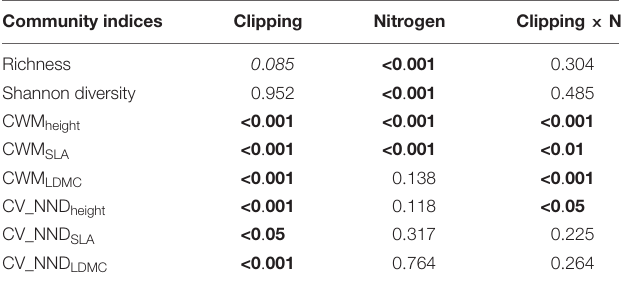
TABLE 1 | P -values of two-way ANOVA to evaluate the effect of clipping, nitrogen addition and their interaction on community indices. Community indices Clipping